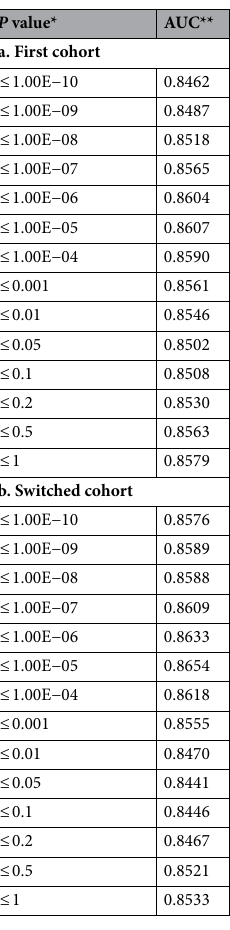
Table 1. The AUCs of different cutoffs of T1D association P values. *The P values are based on the statistics of the PRS training cohort. **The AUCs are the PRS performances in the independent testing